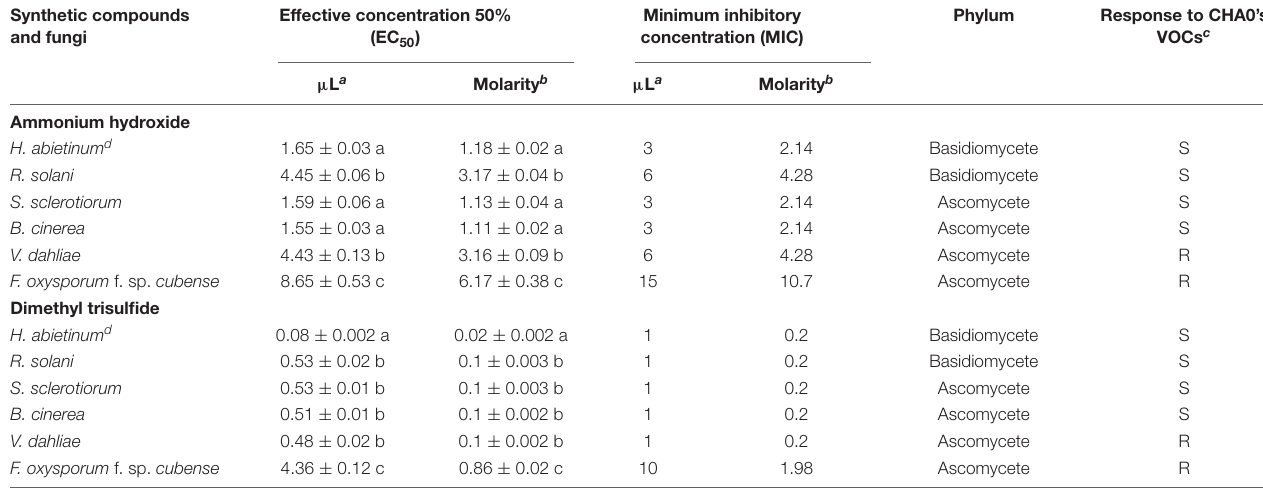
TABLE 3 | Experiment I. In vitro toxicity of ammonium hydroxide and dimethyl trisulfide against Heterobasidion abietinum and other fungi. Synthetic compounds and